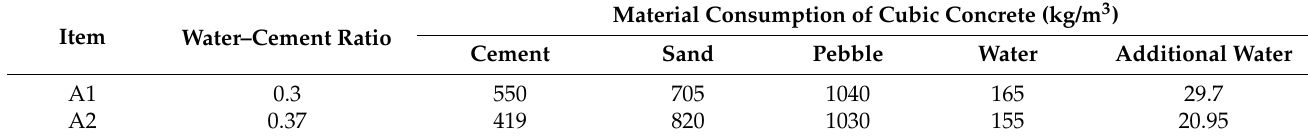
Table 2. Mix proportion of cement concrete.